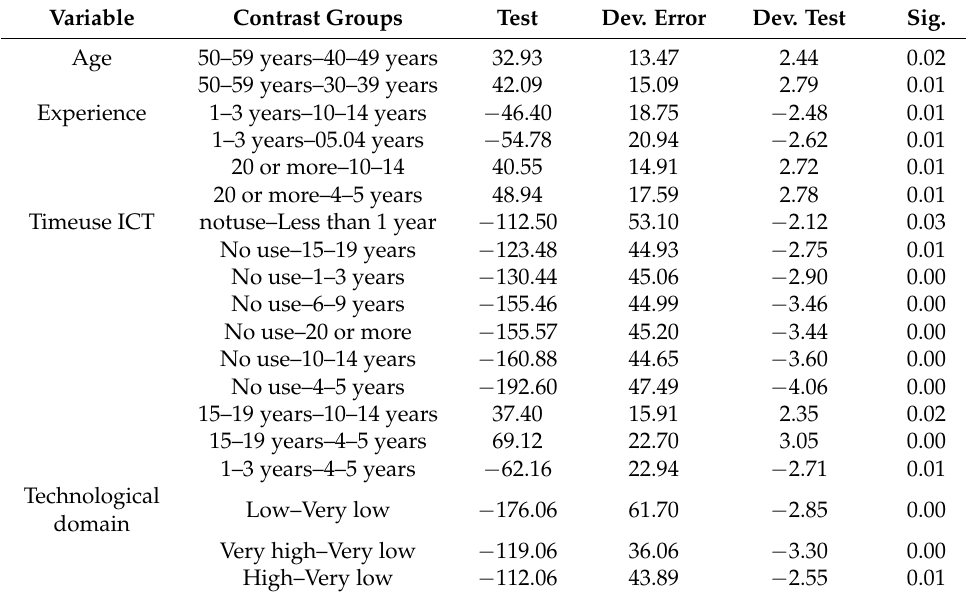
Table 7. Significant results between the variables under study and the DTC shown by the Health Sciences